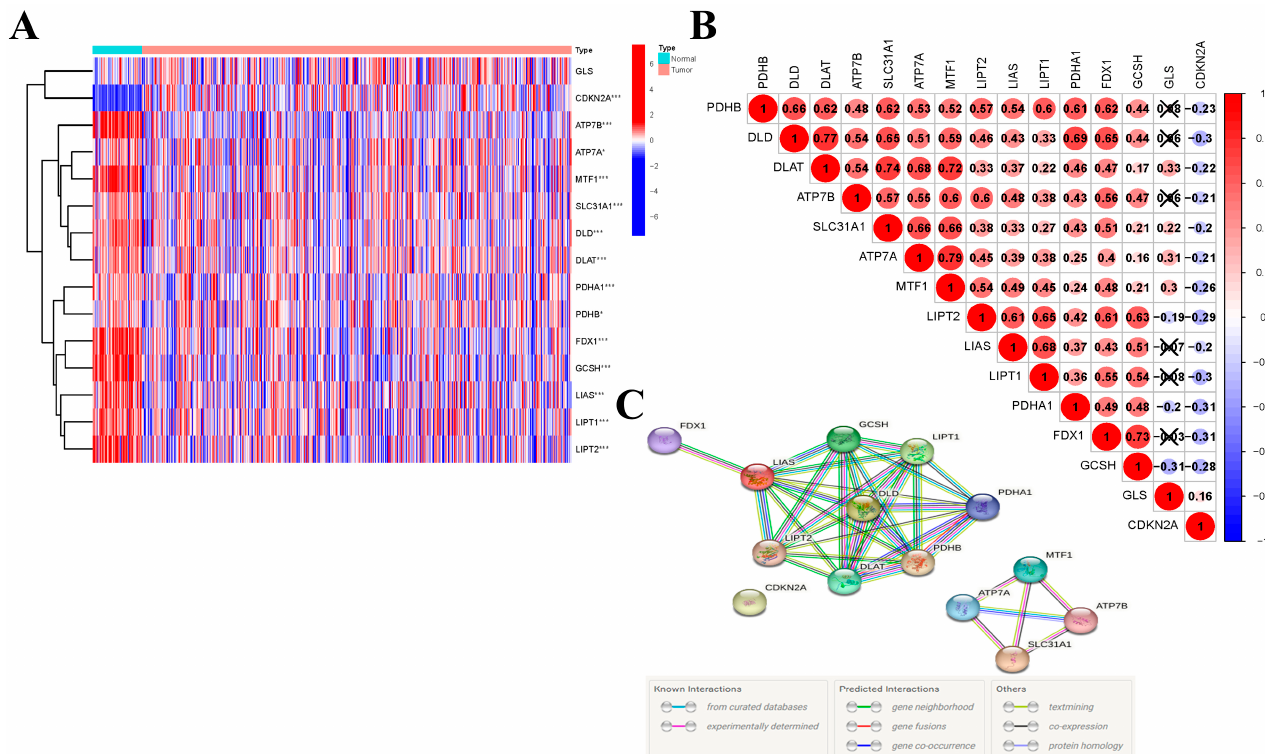
Figure 1. Expression of the cuproptosis-related genes in thyroid carcinoma (THCA). ( A ) The heatmap showed the expression levels of 15 cuproptosis-related genes in normal and tumor samples. * if p < 0.05, and *** if p < 0.001. ( B ) Pearson correlation analysis of the 15 cuproptosis-related genes in THCA. ( C ) PPI network indicated the interactions of the cuproptosis-related genes.